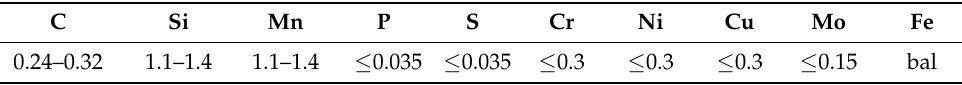
Table 3. Chemical composition of 27SiMn steel (wt%).